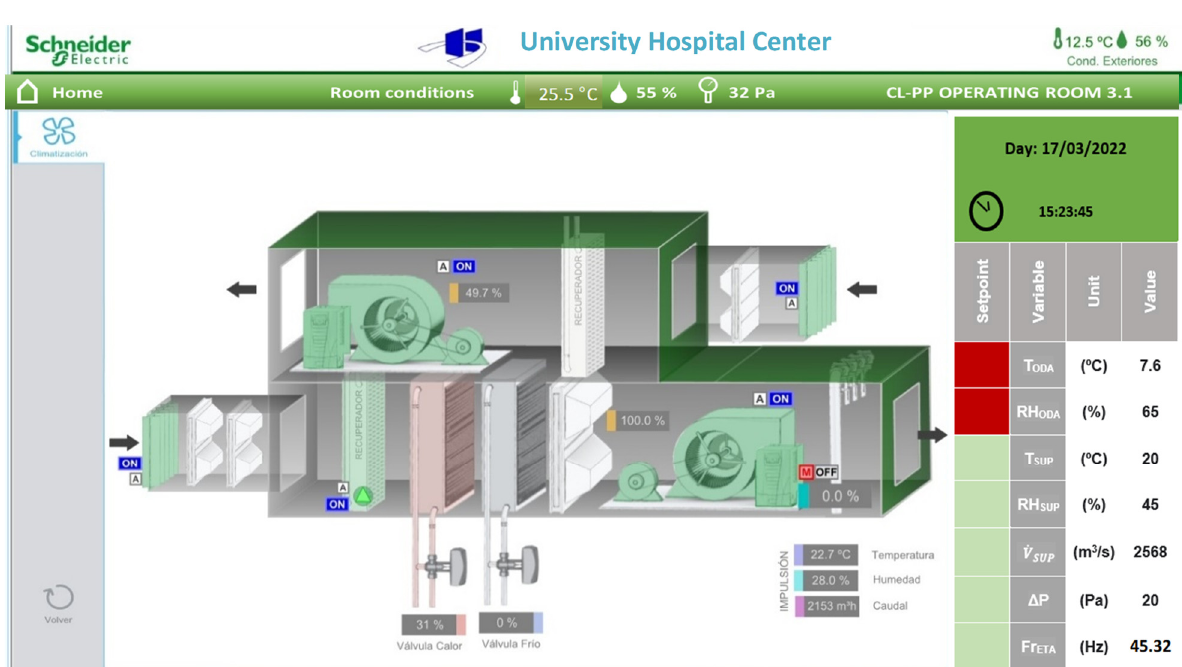
Figure 4. SCADA screenshot, OR 3.1.